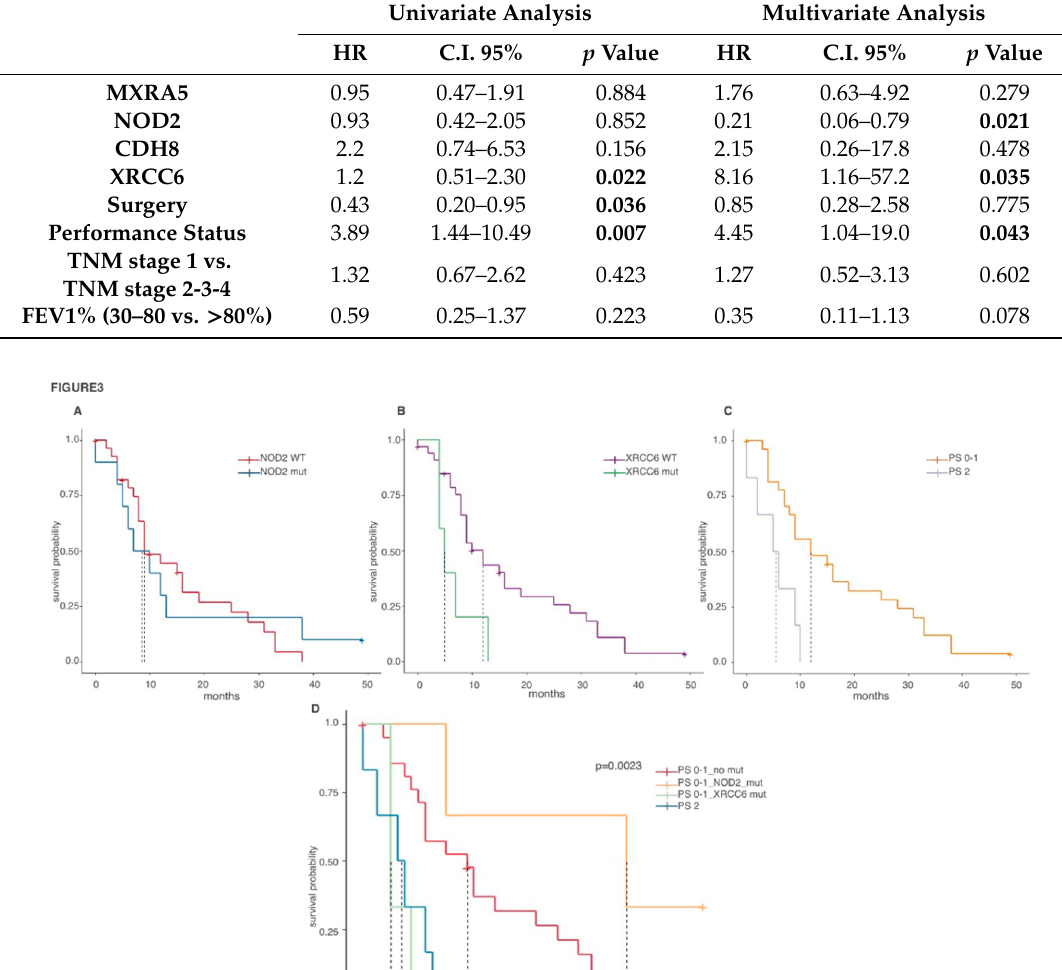
Table 3. Univariate and multivariate survival analysis of biphasic mesotheliomas.